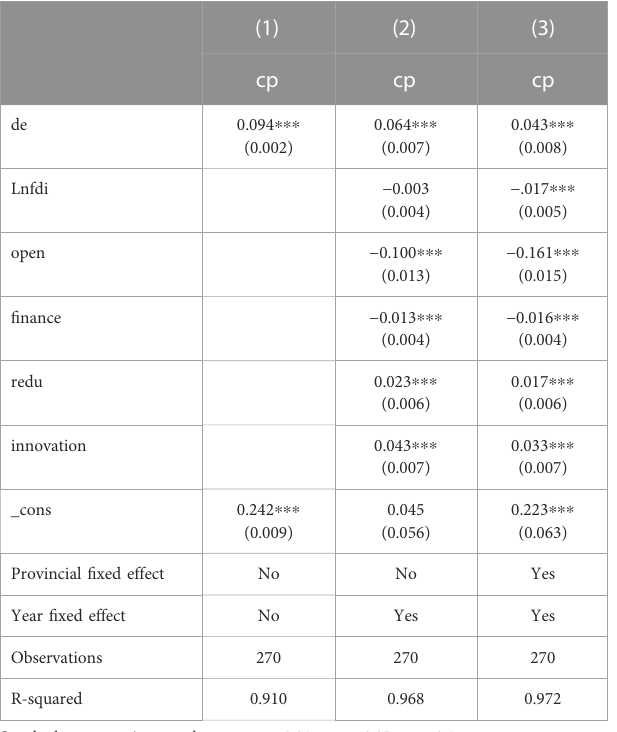
TABLE 5 Benchmark regression of digital economy and common prosperity.